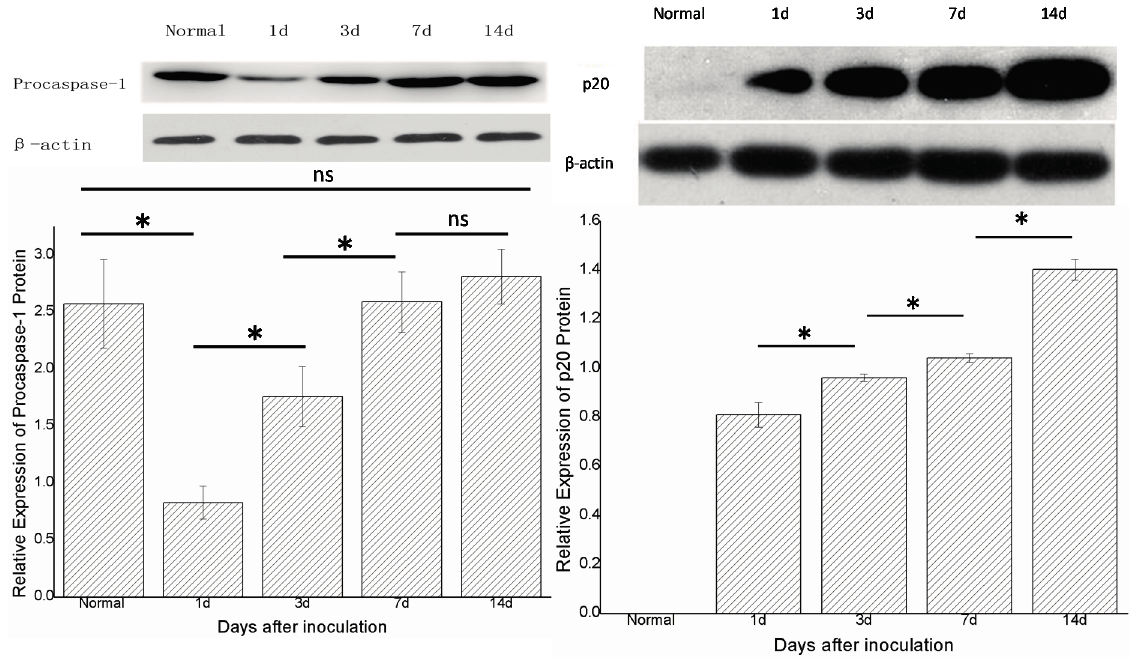
Figure 5. The expression of caspase-1 protein (also called procaspase-1 before caspase-1 was activated) and the fragment of procaspase-1 (p20) and caspase-1 mRNA in the right nasal mucosa of mice. ( A ) Western blot assessment of the protein expression of procaspase-1 and p20 in the control group (group A), and 1, 3, 7, and 14 days (groups B, C, D and E, respectively) after stimulation with Staphylococcus aureus . A semi-quantitative analysis was used to represent the total protein level of procaspase-1 and p20; ( B ) Immunofluorescence showed that caspase-1 was mainly expressed in the cytoplasm of cells in the nasal mucosa; and ( C ) Real-time PCR assessment of the mRNA expression of caspase-1 in the control group (group A), and 1, 3, 7, and 14 days (groups B, C, D, and E, respectively) after stimulation with Staphylococcus aureus (* indicates p < 0.05; ns = not statistically